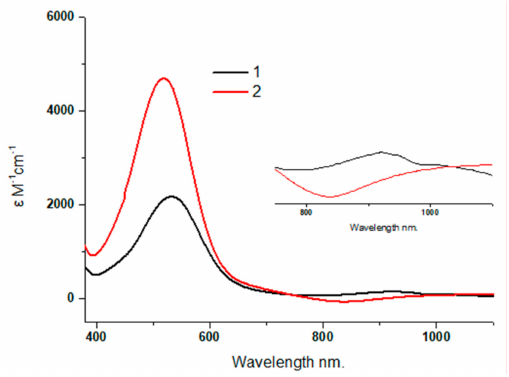
Figure 2. UV-Vis spectra of complexes 1 ( black ) and 2 ( red ) in DMF.